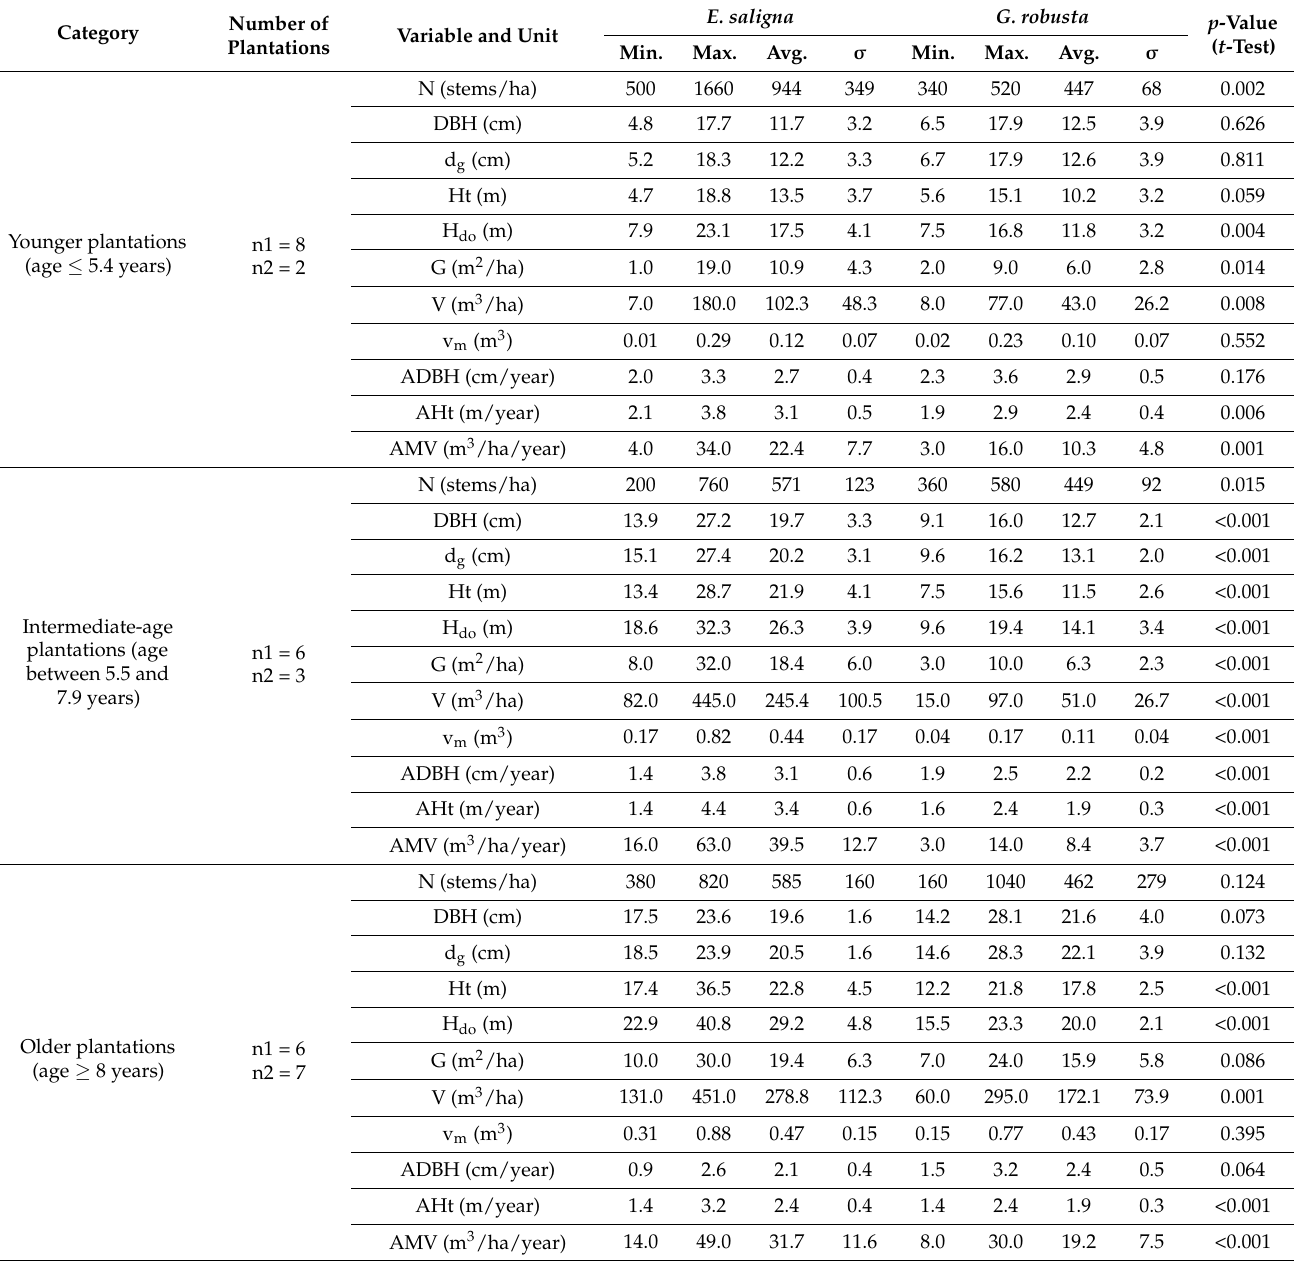
Table 2. Dendrometric characteristics of the studied stands by age class category. Max.: maximum value; Min.: minimum value; Avg.: arithmetic average; σ : standard deviation; n1: number of E. saligna plantations; n2: number of G. robusta